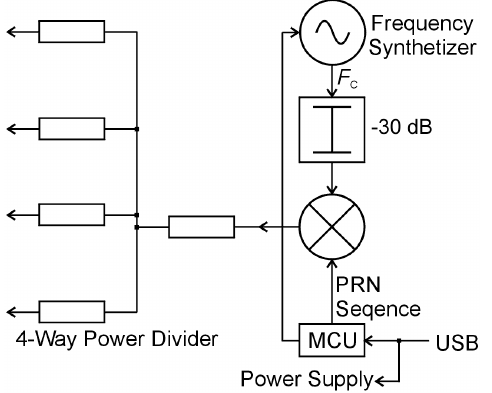
Figure 5. Internal structure of the training signal generator.